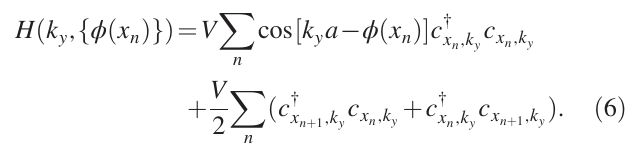
Figure 3(a) is the projection of such a dispersion relation onto the ω - k plane. Figure 3(b) corresponds to uniform y ˆ y . The dispersion relation is A ¼ ð ϕ =a Þ ˆ y ≡ A y Figure 3(b) is the projection of this dispersion relation onto the ω - k plane. Comparing Fig. 3(a) with Fig. 3(b), we see y that the effect of the gauge potential is a shift of the light cone along the k axis by A . y y